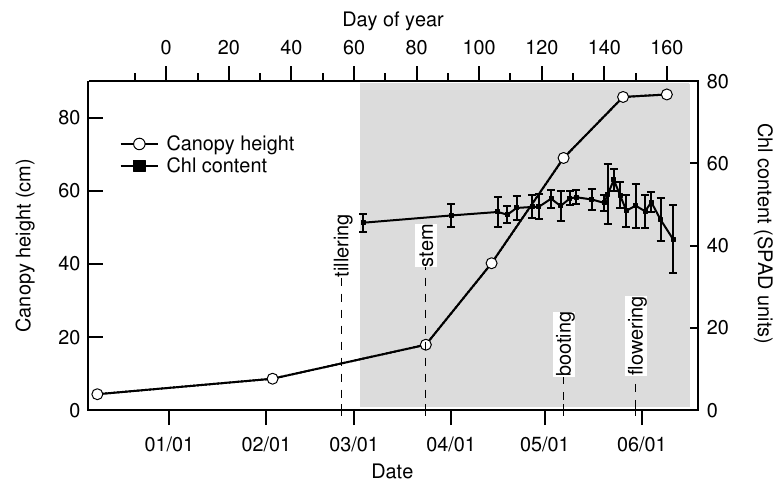
Figure 1. Development of the wheat crop during measurement campaign: open circles: vegetation height; filled squares: leaf chlorophyll (Chl) content. Bars indicate ± one standard deviation; gray zone indicates measurements campaign.